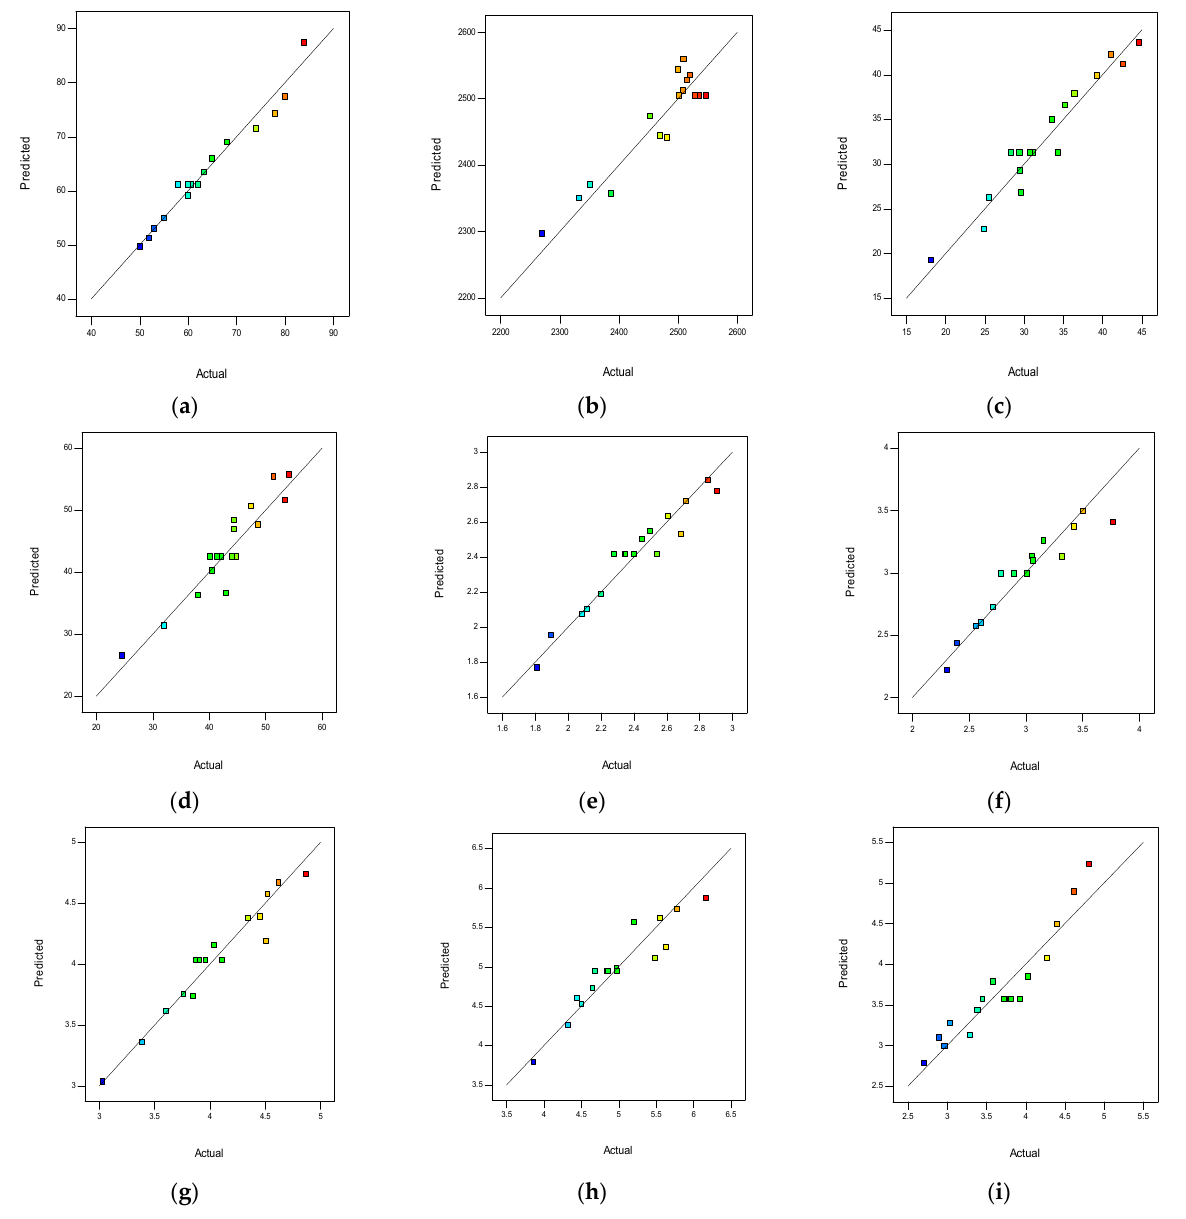
Figure 5. Predicted Versus Actual Plots. ( a ) Slump, ( b ) Fresh Density, ( c ) 7-day Compressive Strength, ( d ) 28-day Compressive Strength, ( e ) 7-day Split Tensile Strength, ( f ) 28-day Split Tensile Strength, ( g ) 7-day Flexural Strength, ( h ) 28-day Flexural Strength, ( i ) Water absorption.